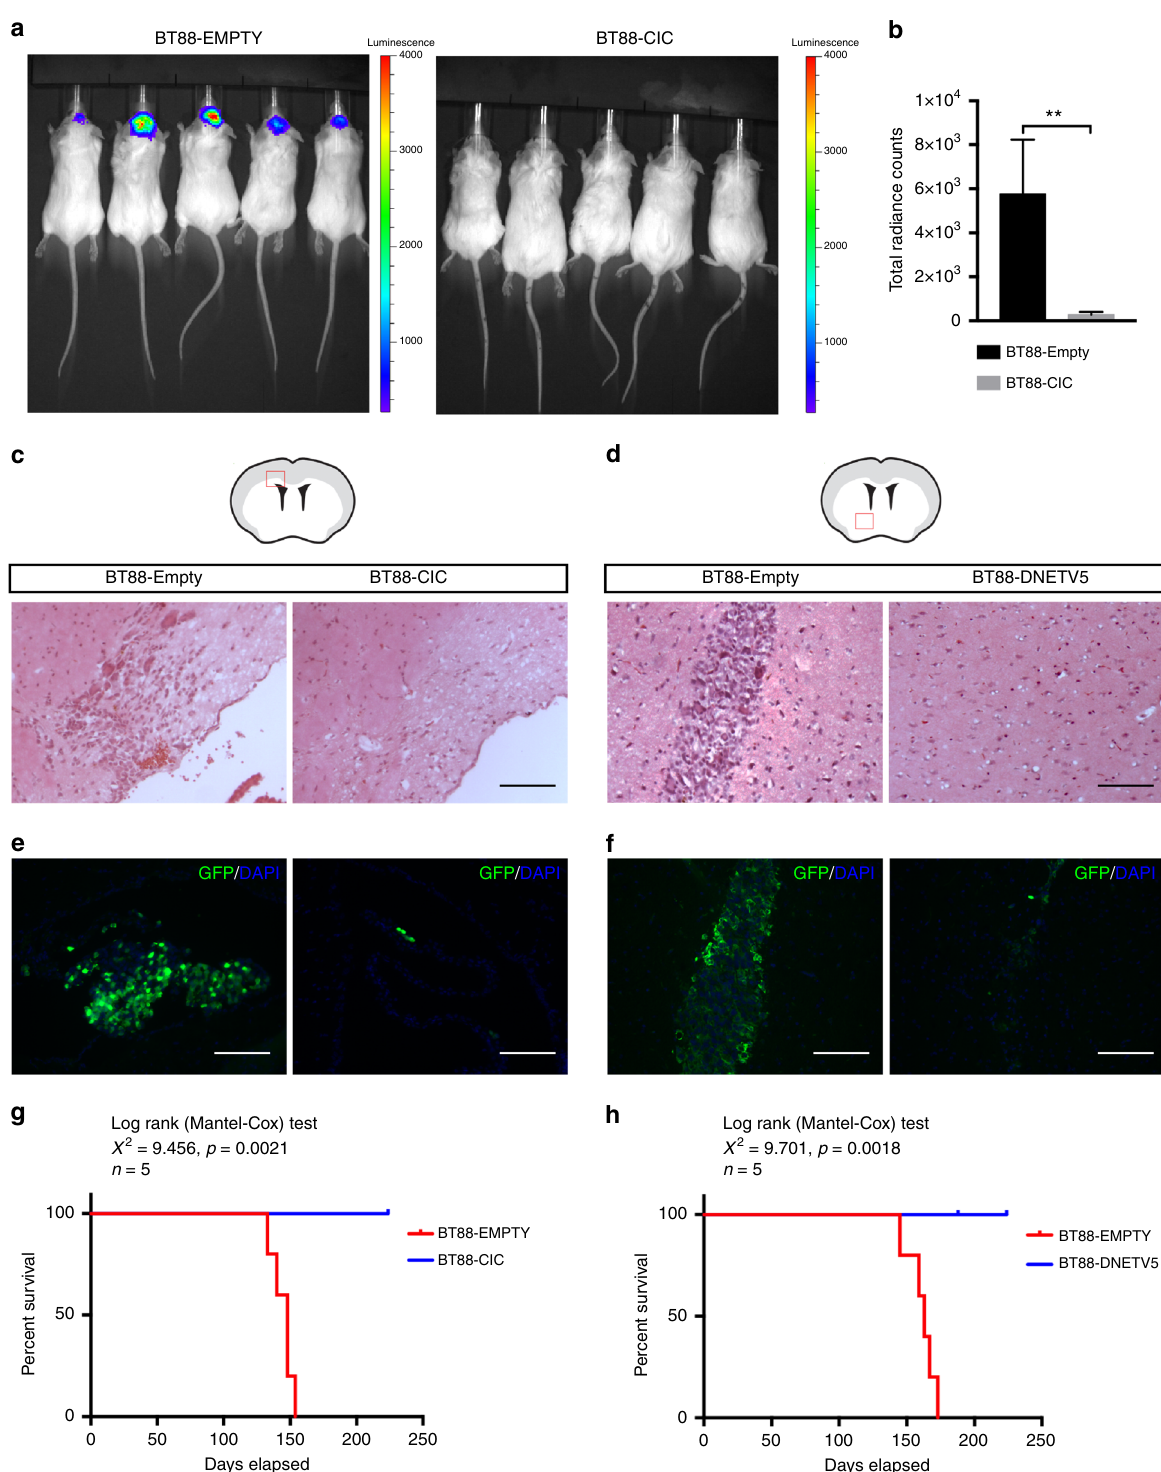
Fig. 10 Tumorigenicity of ODG cells is reduced by CIC re-expression or ETV5 blockade. a , b Bioluminescence imaging of NOD-SCID mice at 6 weeks post- orthotopic implantation of BT88 oligodendroglioma cells stably transfected with empty-GFP-luciferase or CIC-GFP-luciferase. Representative images a and luminescence data b from fi ve mice per cohort. Data shown as mean ± SD. Statistical analyses by student ’ s t test. ** p < 0.01. c , e Representative images of brain sections from mice implanted with control-GFP-luciferase BT88 cells or CIC-GFP-luciferase BT88 cells stained with H&E c or GFP e at 6 weeks post implant. Scale bars: 50 μ m. d , f Representative images of brain sections from mice implanted with control-GFP-luciferase BT88 cells or DNETV5-GFP stained with H&E d or GFP f at 6 weeks post implant. Scale bars: 50 μ m. g Kaplan – Meier survival analysis of mice implanted with BT88 cell transfected with empty-GFP-luciferase or CIC-GFP-luciferase. n = 5 mice per cohort. Statistical analysis by log-rank (Mantel – Cox) test; p = 0.0021. h Kaplan – Meier survival analysis for BT88 cell transfected with empty-GFP or DNETV5-GFP. n = 5 mice per cohort. Source data are provided as a Source Data fi le.